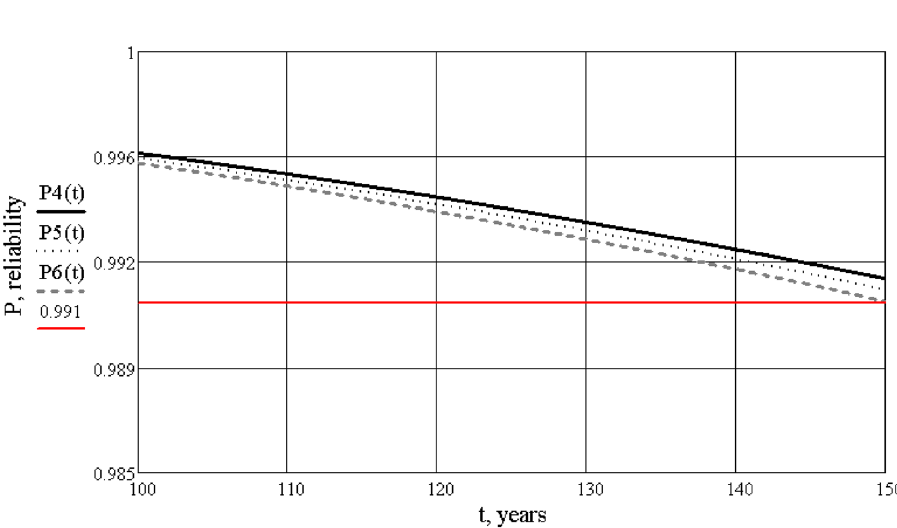
Figure 8. Graphs of reliability dependence of the “building-base system” on time, after